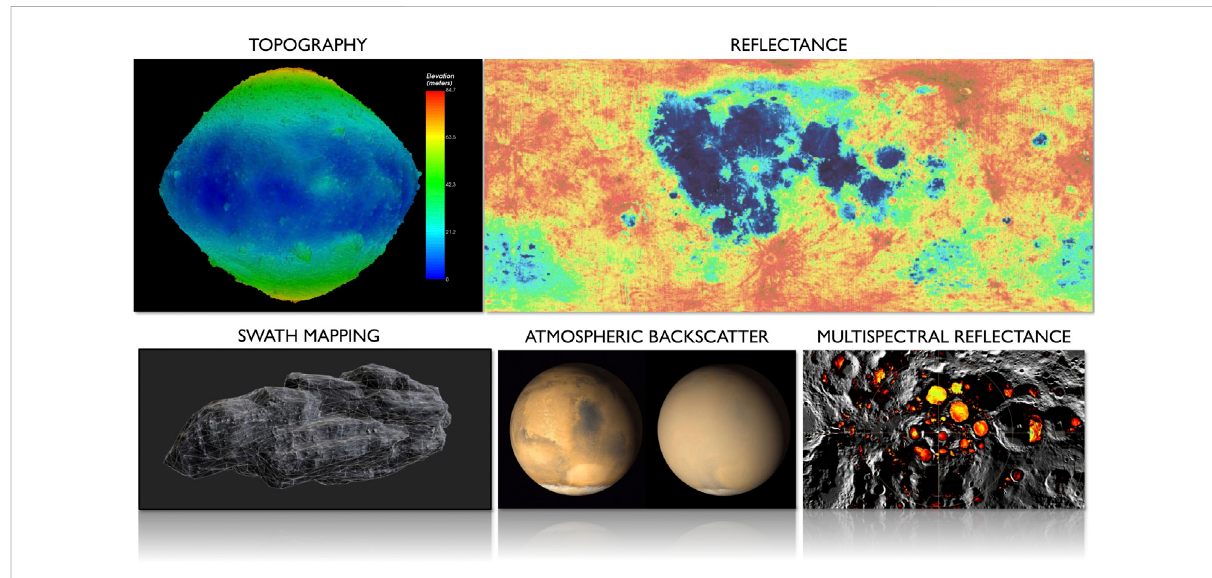
FIGURE 1 Overview of lidar investigations in planetary science. Past and current work focuses on topography (OLA-derived topographic map of asteroid 101955 Bennu, top left) and single-wavelength re fl ectance or normal albedo (LOLA-derived normal albedo map of the Moon, top right). Several future techniques on the horizon include swath-mapping lidar for high spatial resolution and coverage (surface terrain mapping, bottom left), atmospheric backscatter, trace gas, and Doppler measurements (Mars global dust storm, center bottom), and multispectral re fl ectance spectroscopy (permanently shadowed regions at the lunar South Pole, bottom